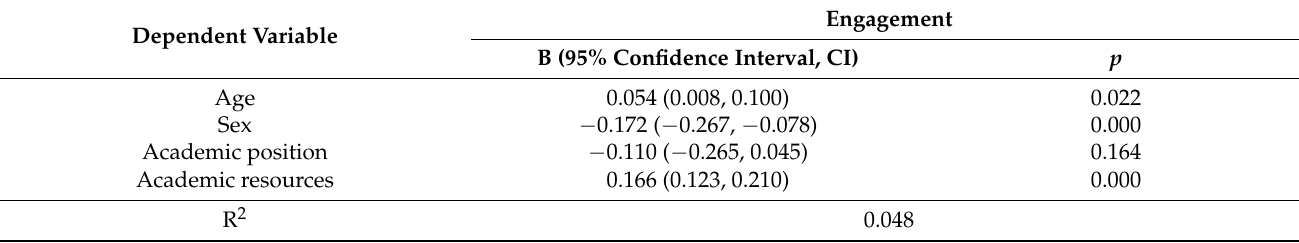
Table 2. Results of regression analysis testing Hypothesis 1.